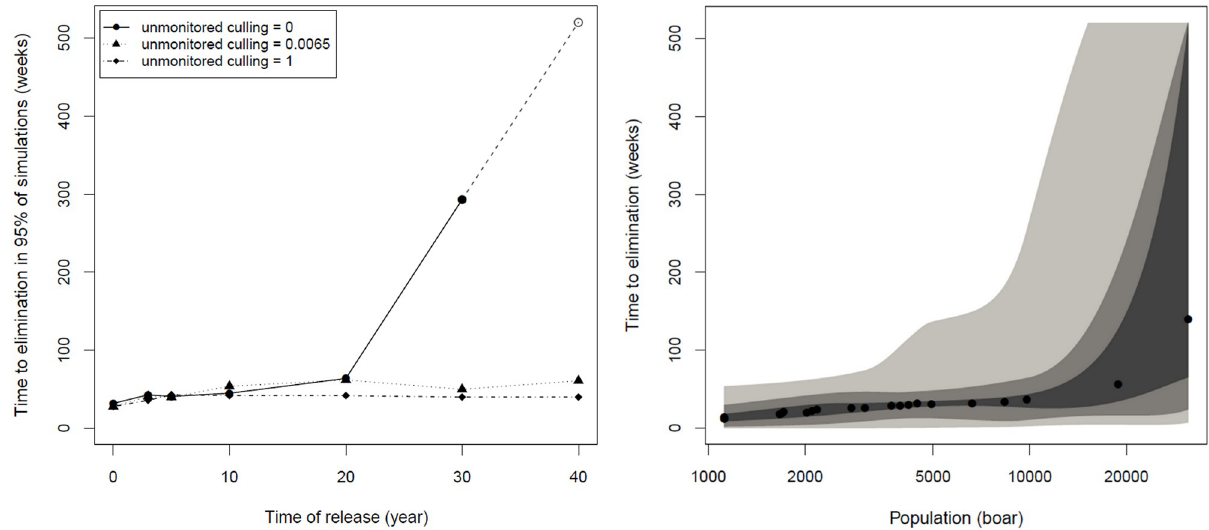
Fig 4. Time to elimination following an outbreak. (Left) Plot shows the time to reach zero infected animals in 95% of model repetitions against year in which a single individual infected with FMD is released into the population for a range of potential management scenarios exploring the impact of unknown culling effort on land beyond the current distribution on publically owned land; culling levels tested simulate no culling (= 0), equal to FC land (= 0.0065) and complete removal (= 1). (Right) Plot shows the median time to reach zero infected animals (dots) against population size at time of release taken across all management scenarios. Shaded regions denote smoothed ranges centred on the median containing (from darkest to lightest): 50%, 90%, and 100% of model repetitions.